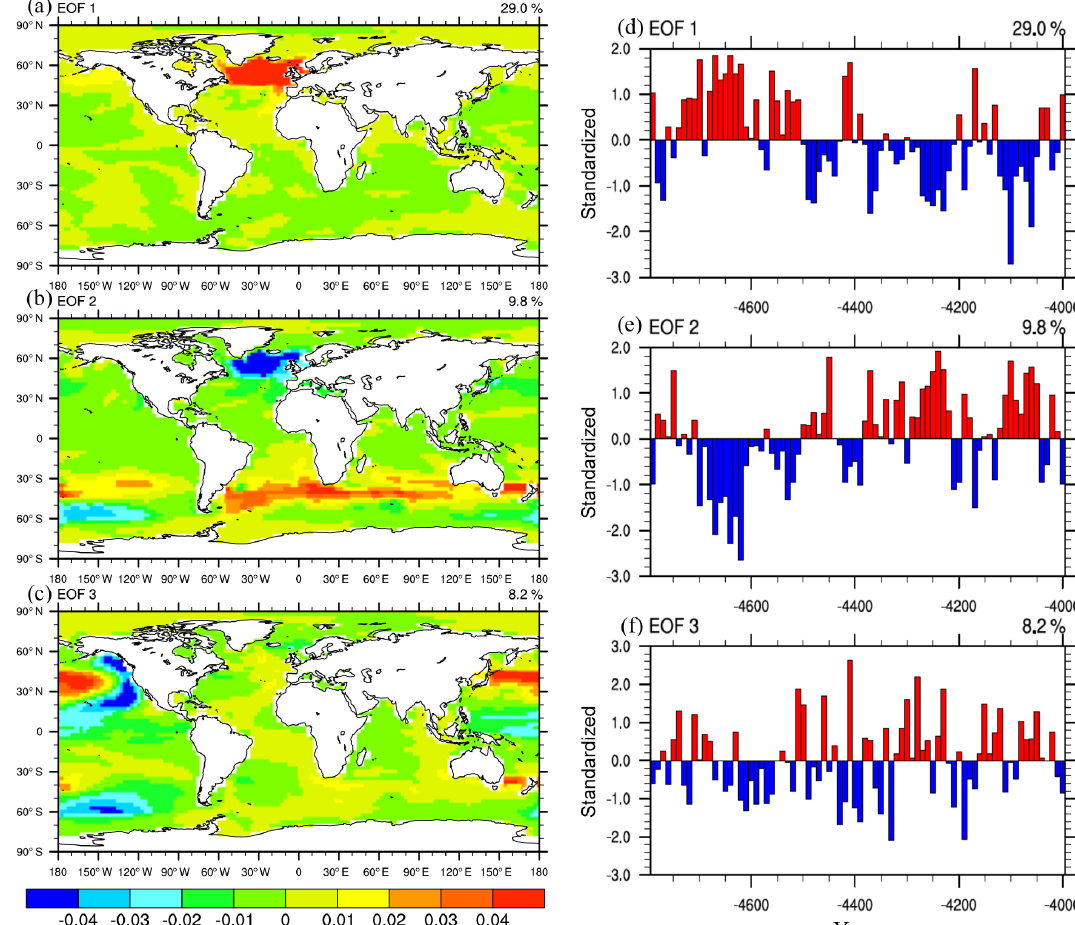
Figure 3. The first three patterns (a–c) and principal components (d–f) of rotated empirical orthogonal function (EOF) modes on the SST over the period